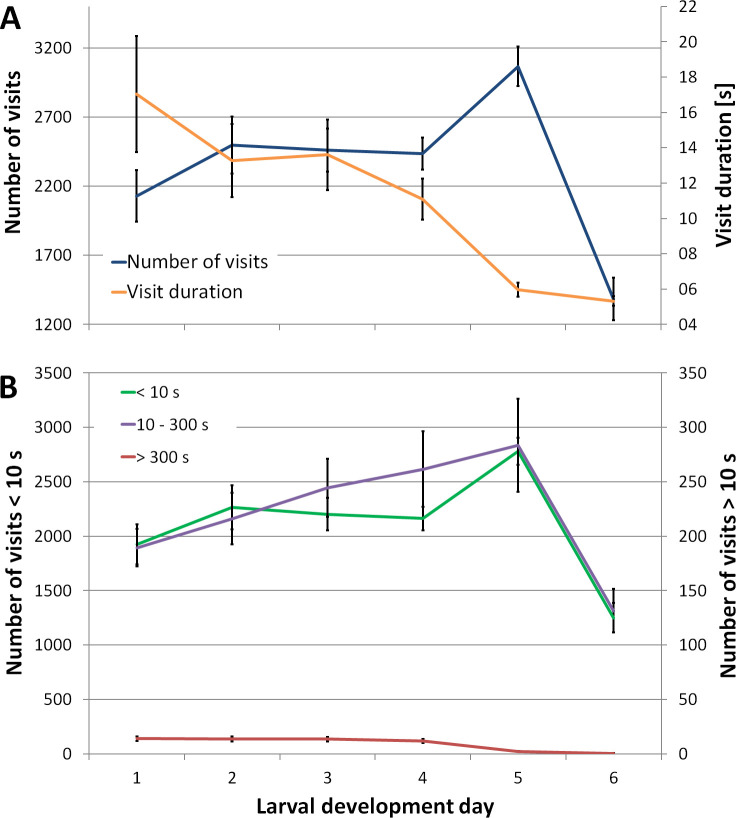
Mean number of visits and visit duration throughout larval development.Larval development was split into six larval development days. A. While the mean number of visits increased from the first to the fifth development day, the mean visit duration decreased by two thirds in this timespan. B. Visits of short duration (< 10 seconds) were tenfold higher than those combined of medium (10–300 seconds) and long (> 300 seconds) duration. The number of cells = 52 in 3 colonies recorded during 2016 and 2018.